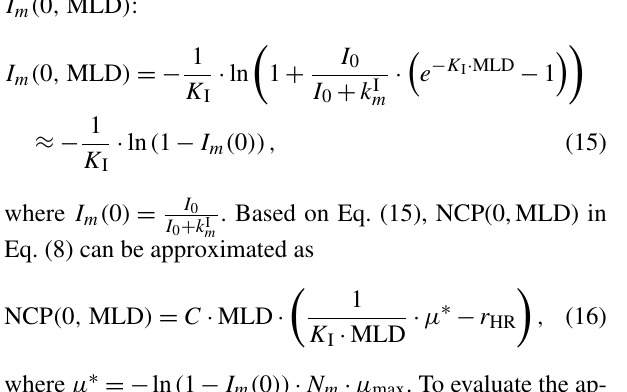
Figure 3. Upper bounds derived using the original and approxi- mated models. The upper bound for the original model (Eqs. 8– 10) is estimated through a nonlinear optimization approach. The upper bound for the approximated model is calculated analytically from Eq. (19). The models use the constants listed in Table 1 and I m ( 0 ) = 0 . 9. Decreasing I m ( 0 ) and increasing r HR results in greater discrepancies between the original and approximated models in re- gions with shallow mixed